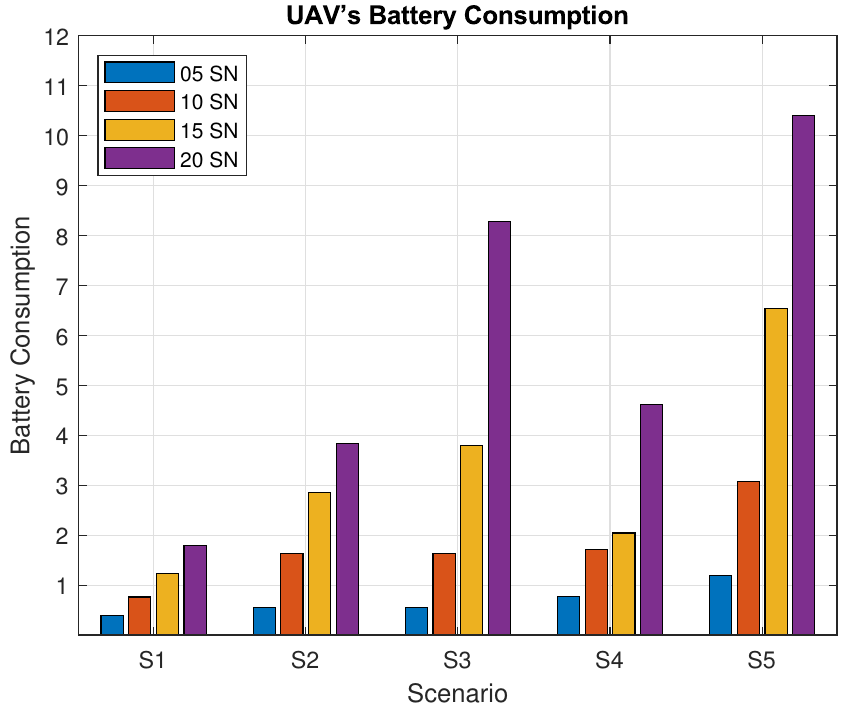
Figure 13. Number of UAVs used in